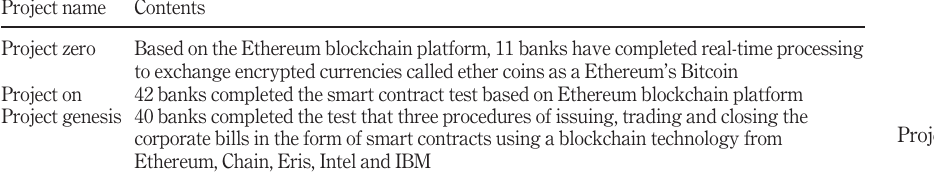
Table I. Project examples